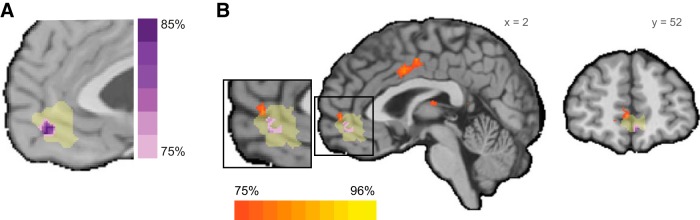
Cross-modality classification results; n = 26. To establish a common representation across sensory modalities, we conducted a cross-modality classification analysis. A SVM trained to classify high- from low-value trials of one sensory modality and tested on the other. Hence, significant voxels are sensitive to value and not sensitive to sensory modality. A, Results from a vmPFC-only analysis. A probability map for a voxel to be significant across subjects, at a threshold of 75% and up (in purple). In yellow, the area of the vmPFC mask. The map is shown at MNI coordinate x = −3. B, Results from a whole-brain analysis (in orange), superimposed on the vmPFC-only result (in purple).